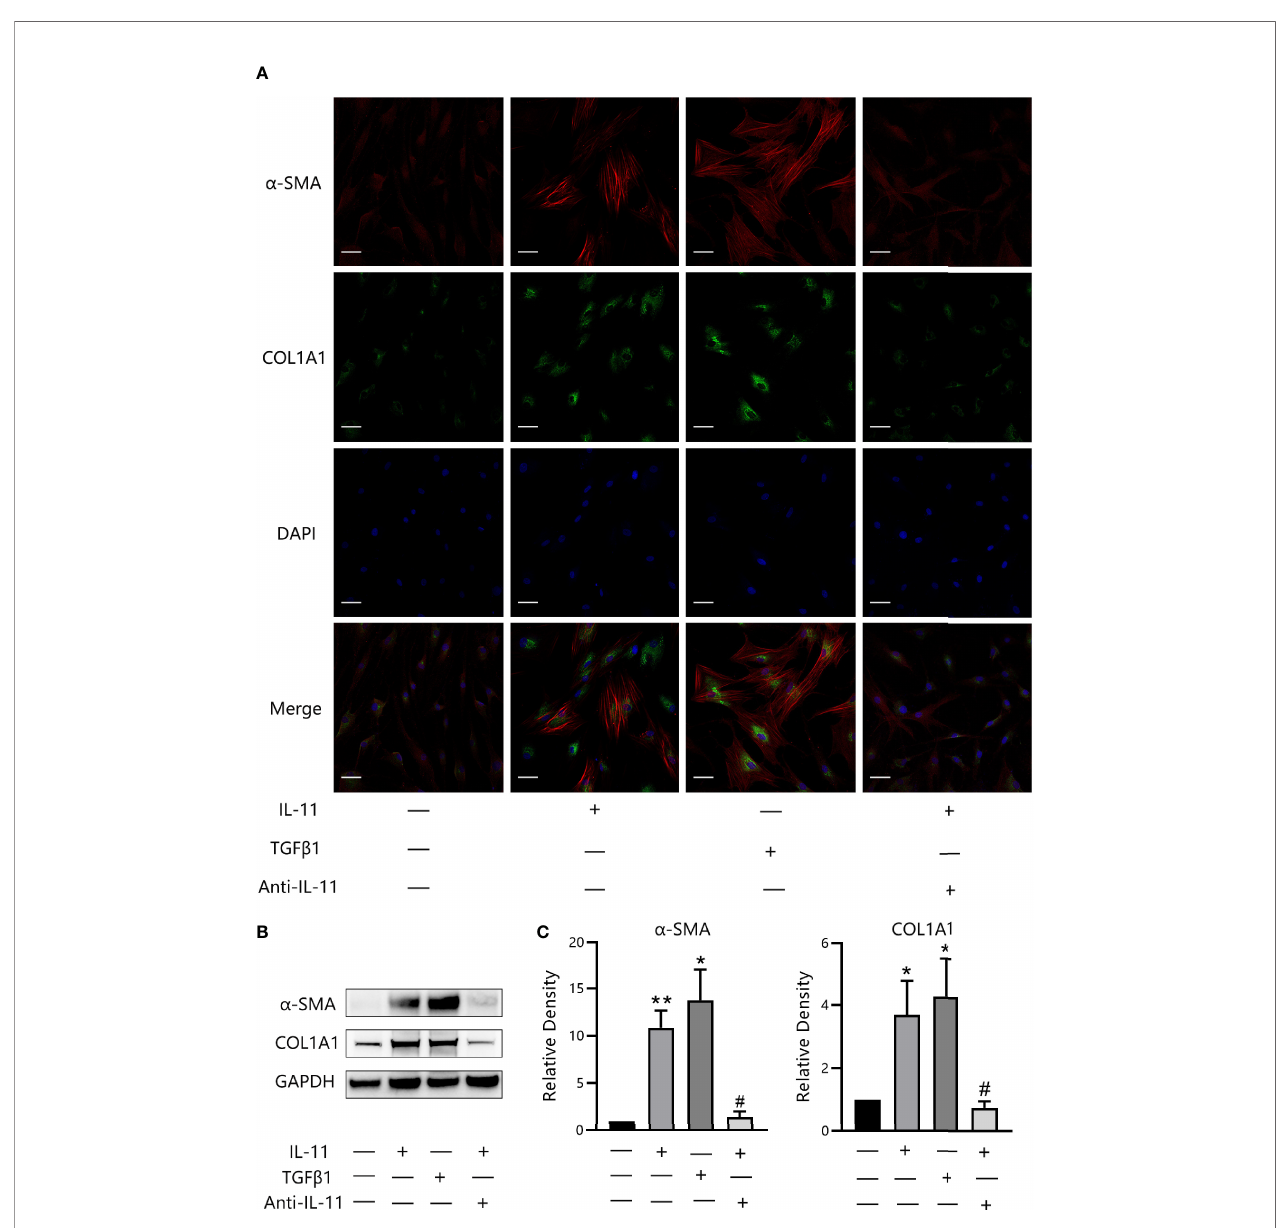
FIGURE 5 | IL-11 induces trans-differentiation of orbital fi broblasts (OFs) to myo fi broblasts. (A) Representative images of a -SMA or COL1A1 immunostaining in OFs treated with IL-11 (10 ng/mL, 48 h) or TGF b 1 (10 ng/mL, 48 h). Cells were counterstained with DAPI to visualize nuclei. Scale bars, 50 m m. (B) Western blot of a -SMA or COL1A1 expression in IL-11 (10 ng/mL, 48 h) or TGF- b 1(10 ng/mL, 48 h, n = 4) stimulated OFs with or without a 2-h pretreatment with anti-IL-11 neutralizing antibody (anti-IL-11, 15 m g/mL). GAPDH was used as a loading control. (C) The protein levels were quanti fi ed and analyzed. anti-IL-11, anti-IL-11 neutralizing antibody. Data are expressed as mean ± standard deviation (SD). *P < 0.05, **P < 0.01compared with the control; # P < 0.05, compared with IL-11 alone; assessed by Tukey ’ s corrected one-way analysis of